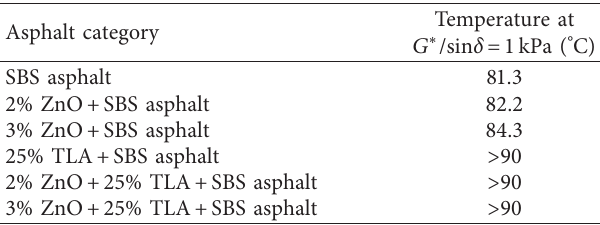
Table 3: High-temperature classification temperature of different